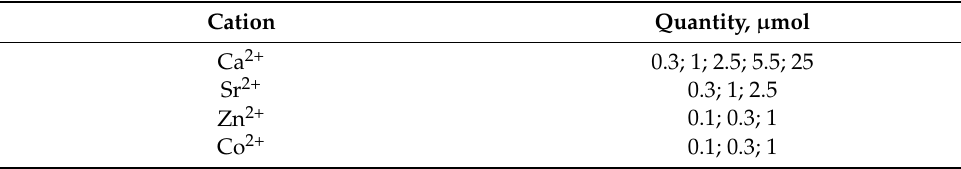
Table 1. The cross-linking ion quantities used in the 1 H NMR